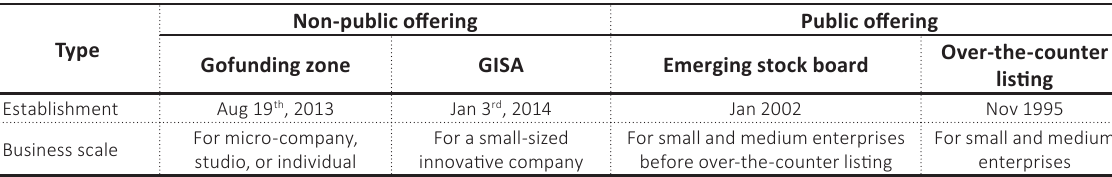
Source: Taiwan Stock Exchange; Taipei